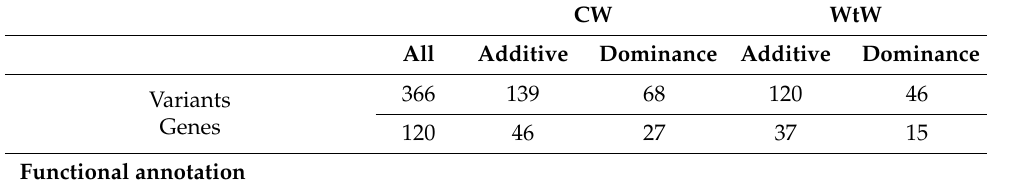
Table 5. Number of variants, affected genes, and functional impact of variants associated 1 with additive and dominance effects on 8-year-old cow weight (CW) and cumulative weight weaned